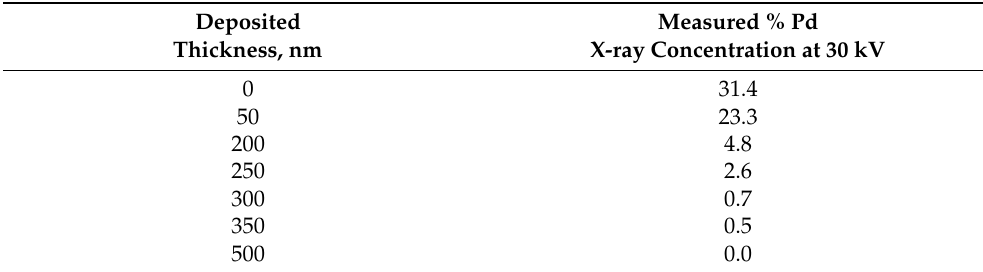
Table 5. % Pd X-ray concentrations at 30 kV for the 7 reference gold strips of known thickness obtained by sputtering.